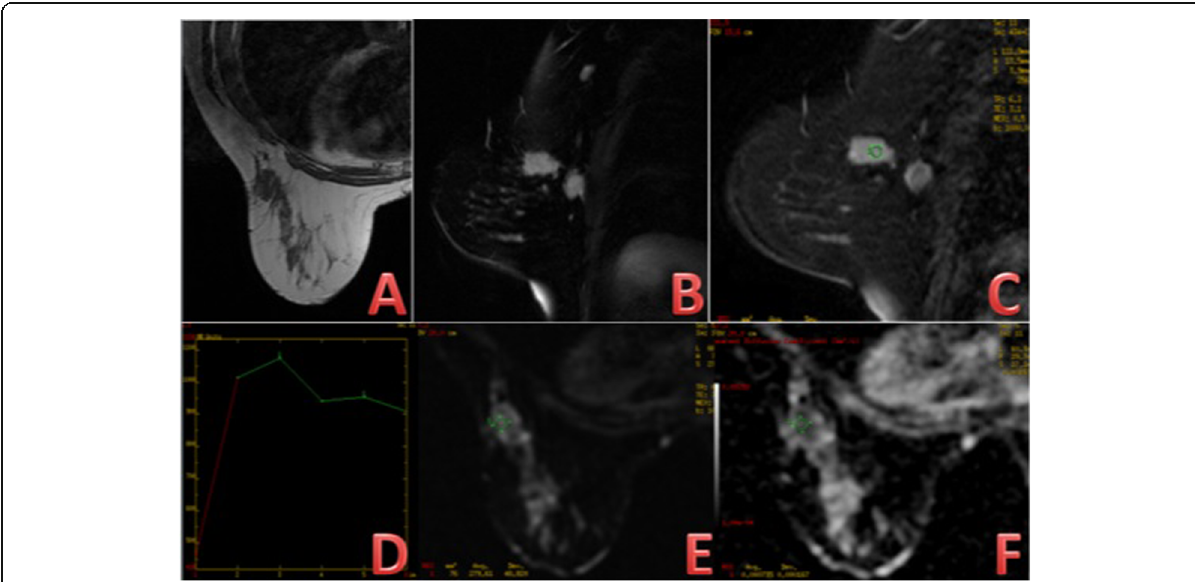
Fig. 3 54-year-old women, grade III neuroendocrine carcinoma, ER ( − ), PR ( − ) c-erb B2 ( − ), high Ki-67 index, and axillary pathological lymph node detected on MRI. Breast density is classified as type b on T1WI axial image ( a ). An irregular shaped lesion, measured 30 mm in diameter, is seen on sagittal fat-saturated T2WI ( b ) and sagittal fat-saturated, post-contrast T1WI ( c ). Kinetic curve of the lesion is type 3 and t peak value is 100 s ( d ). The lesion is hyperintense on DWI ( e ) and hypointense on ADC map ( f